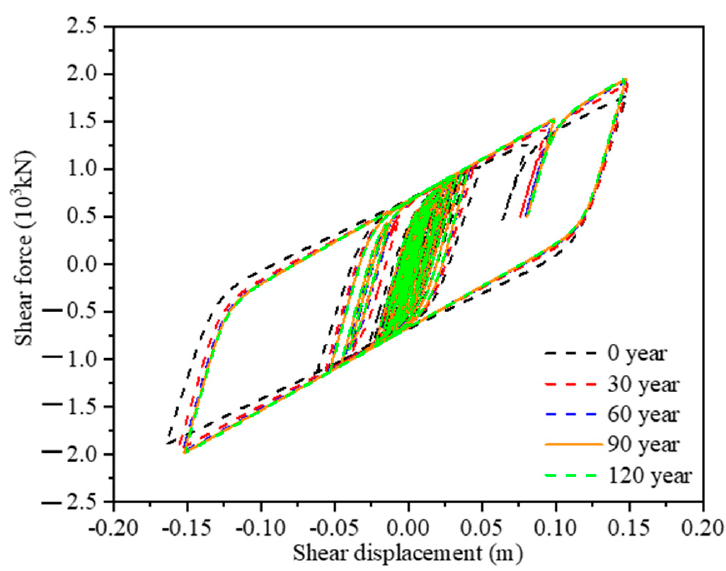
Figure 20. Comparison of the hysteresis curves of the LRB at different deterioration time points.